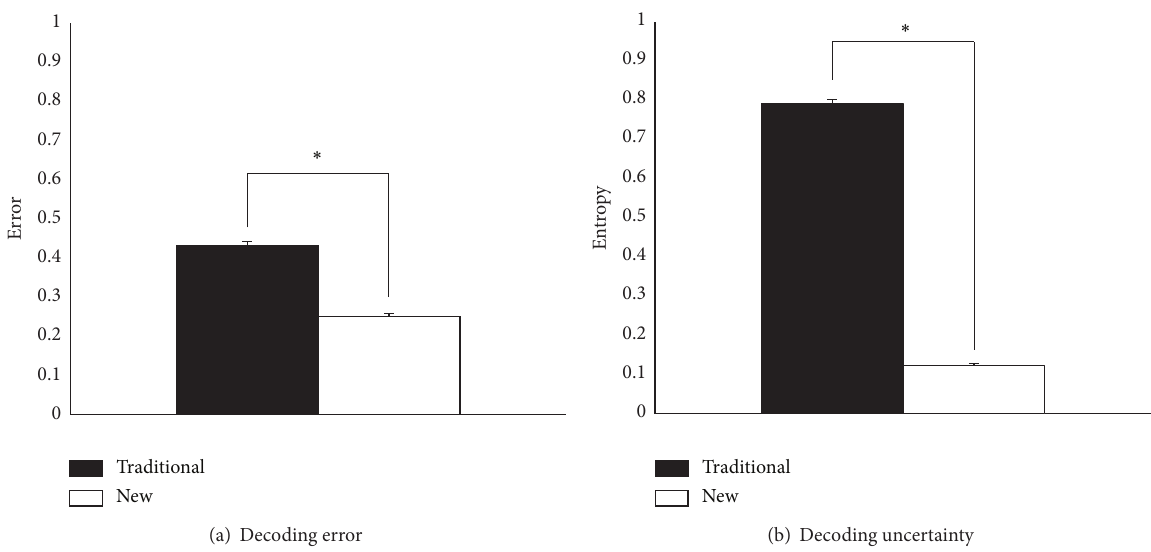
Figure 3: (a) Decoding error rates and (b) uncertainty represented by entropy of decoding output using two decoding models from simulated neural data (see text). The maximum entropy is 1 bit in this case since there are two possible external events. In both categories, there is significant difference in error rates ( 𝑡 -test, 𝑃 < 0.00001 ) between the dynamical maximum entropy decoder (new) and the traditional maximum entropy decoder